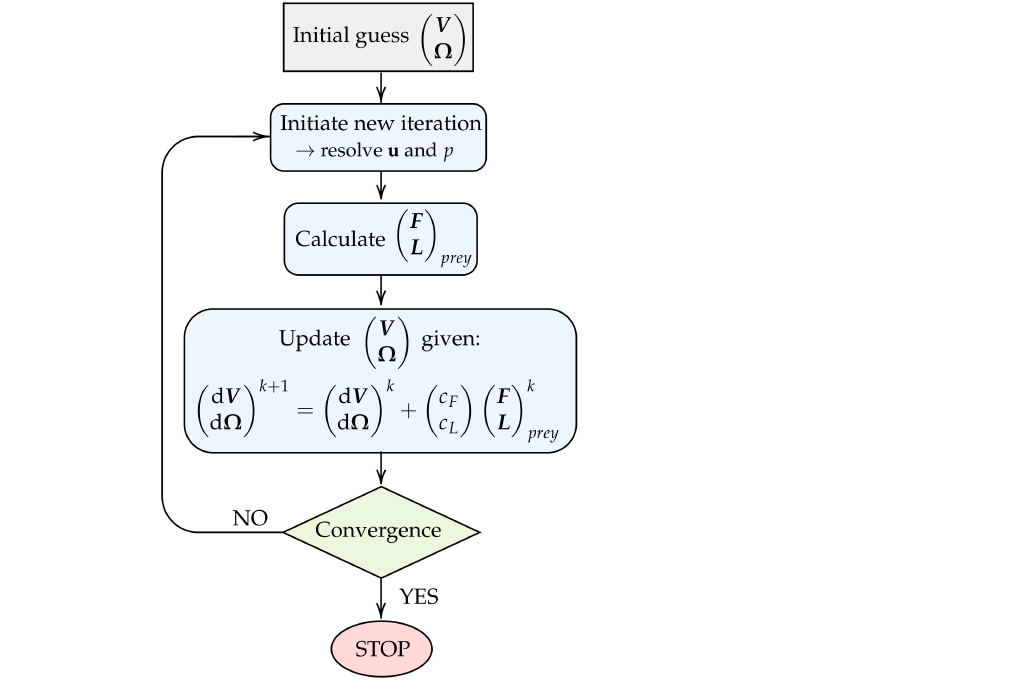
Figure 3. Flowchart illustrating the iterative procedure used to model drifting prey. The chart covers the process for one arbitrary discrete time step. Here, k denotes an iteration